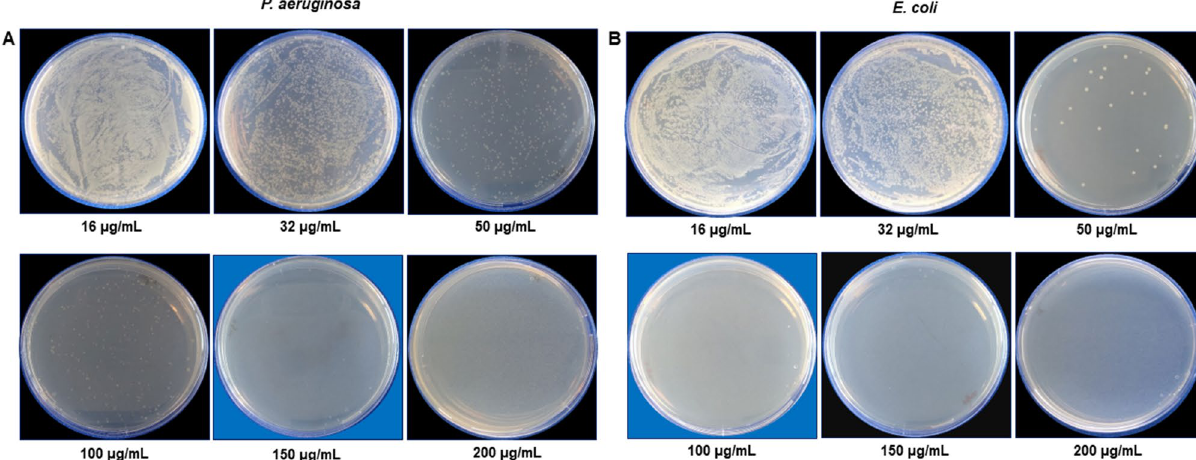
Figure 8. Cell viability test at different concentrations range from 16-200 μg/ml of LV-AgNPs for (A) P. aeruginosa and (B) E. coli. The blue background shows the MBC values of LV-AgNPs against respective pathogens with complete growth